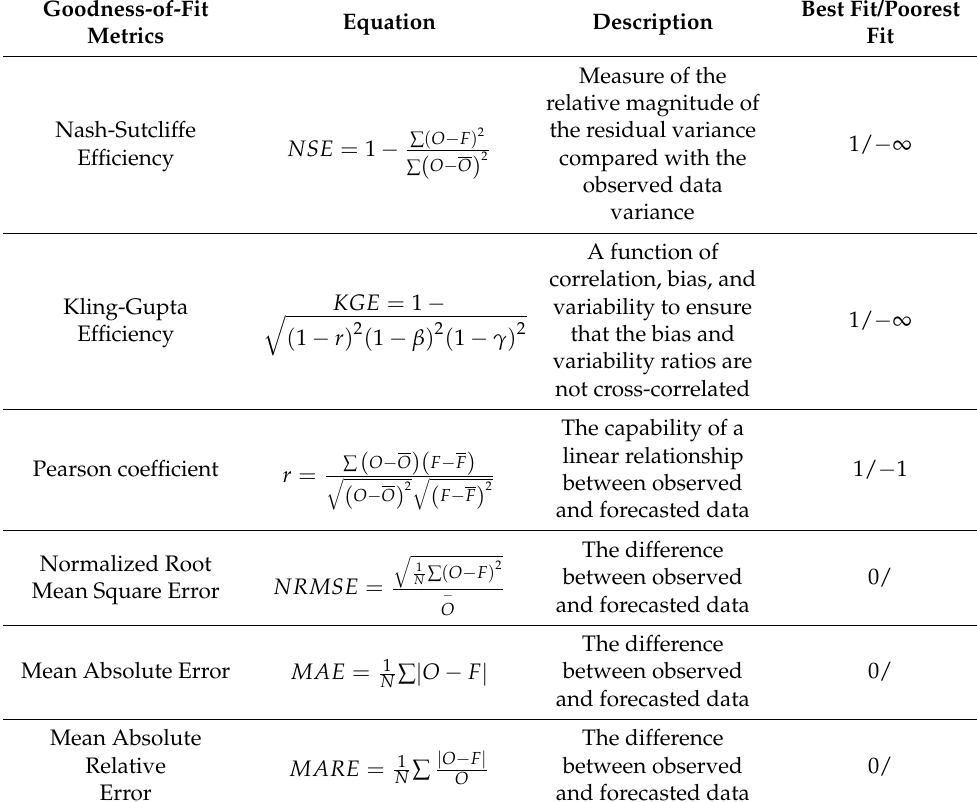
Table 4. Summary of goodness-of-fit metrics used in this research.